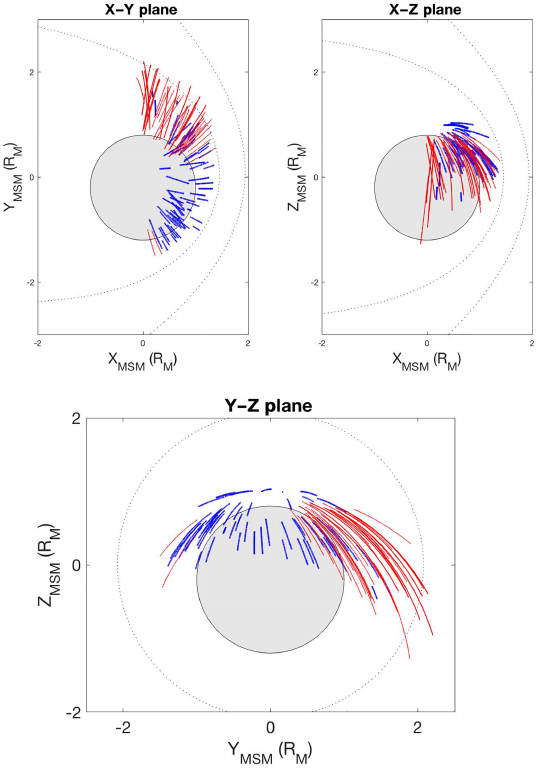
Figure 4. Location of ULF events in three different planes in Mer- cury solar magnetospheric (MSM) coordinates, in which blue lines mark the general ULF waves and red lines mark the KHI-ULF